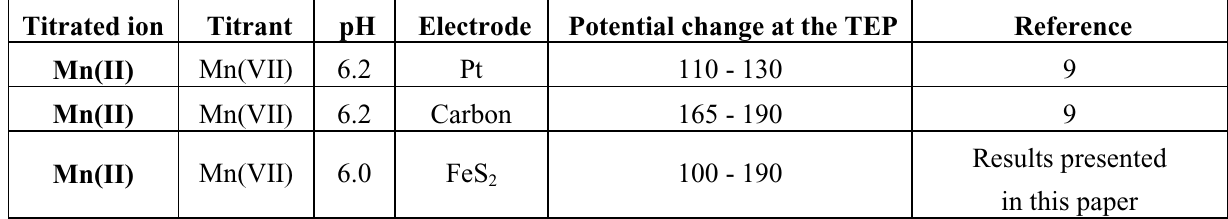
Table 1. Comparison of the results obtained with the pyrite, Pt and carbon indicator electrode in pyrophosphate media.